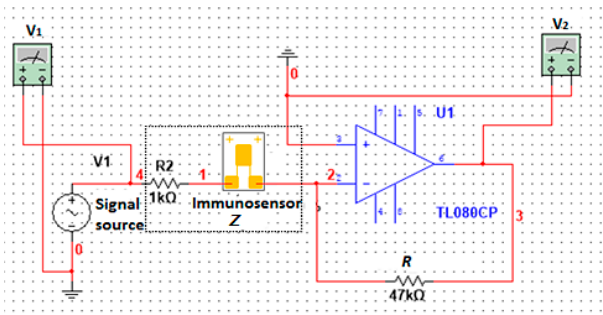
Figure 2. The circuit of impedance measurement for the immunosensor.